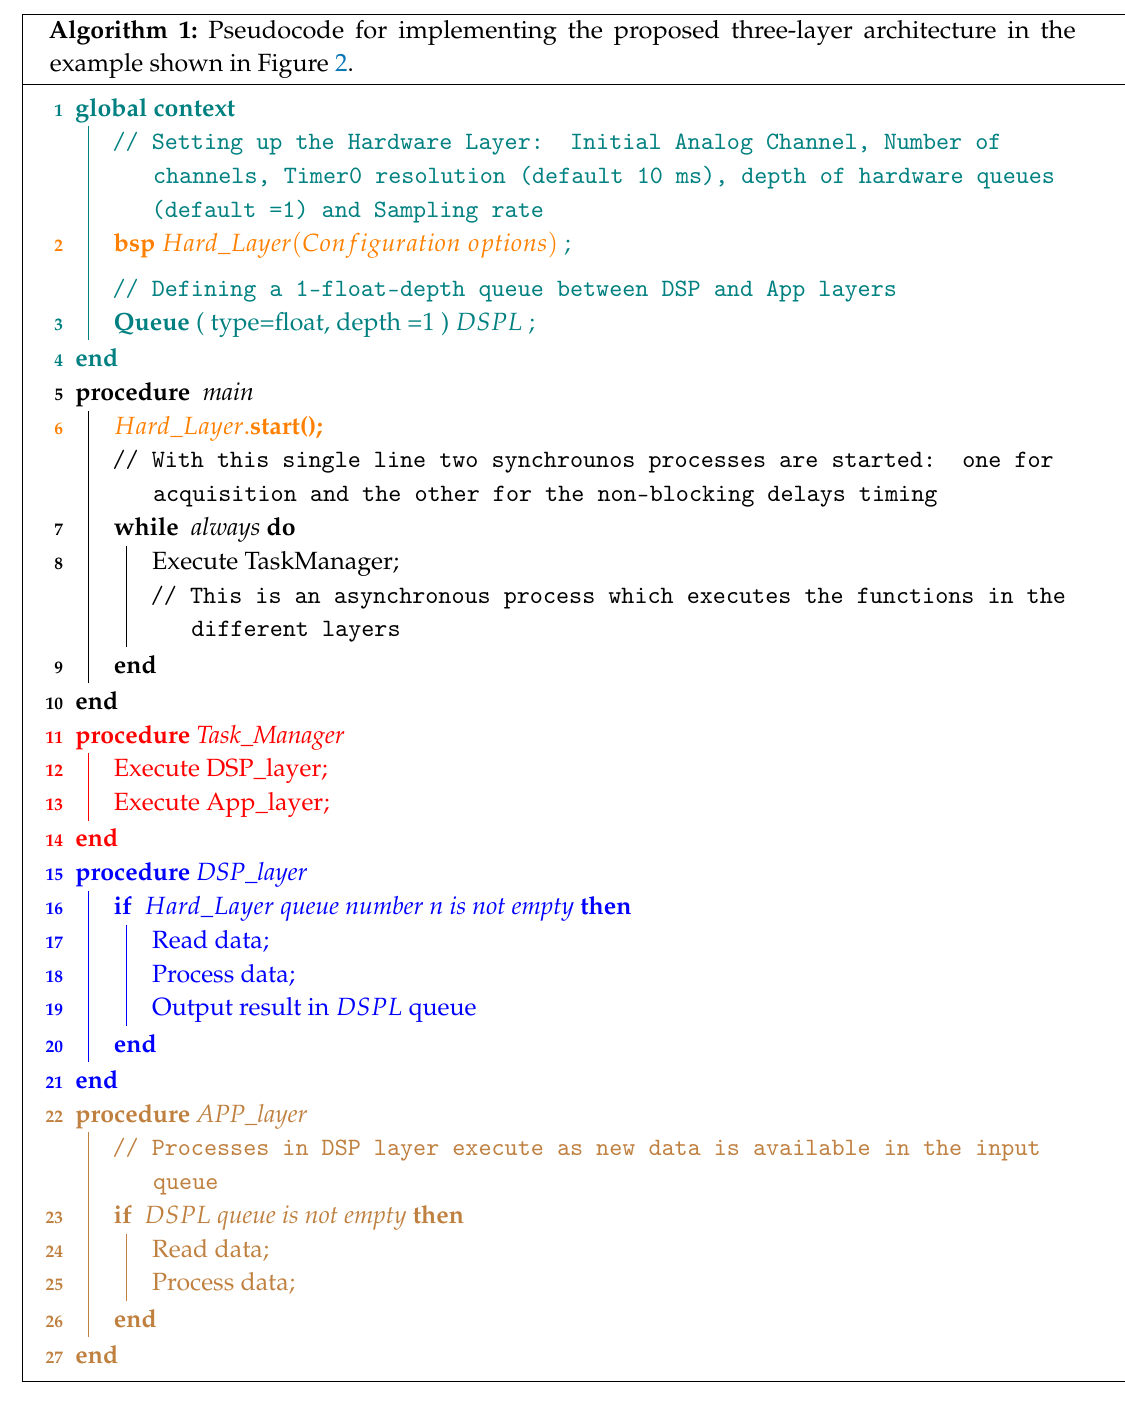
Algorithm 1: Pseudocode for implementing the proposed three-layer architecture in the example shown in Figure